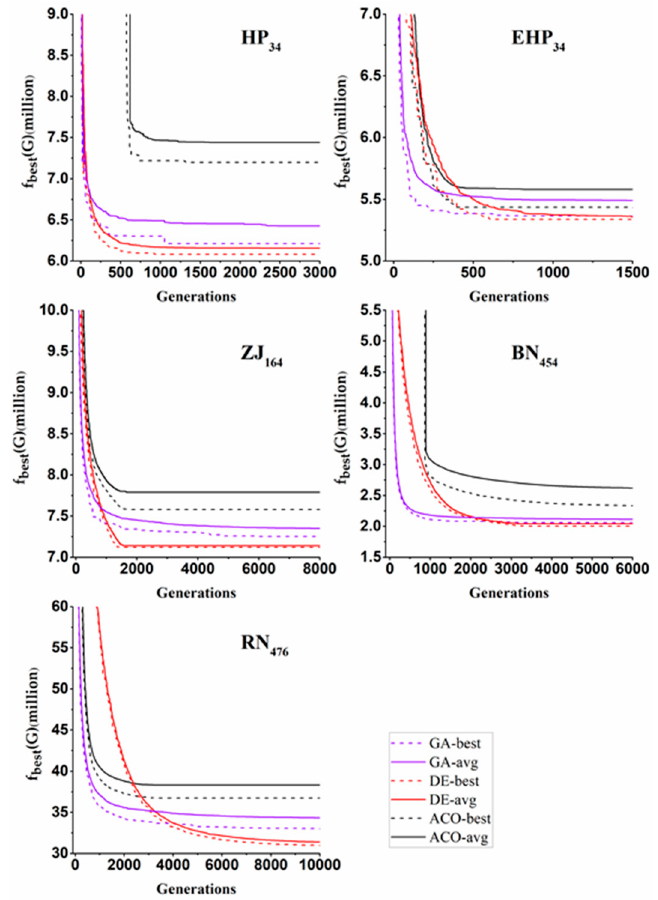
Figure 2. Solution quality metric f best ( G ) of the three di ff erent types of EAs applied to the five case studies.